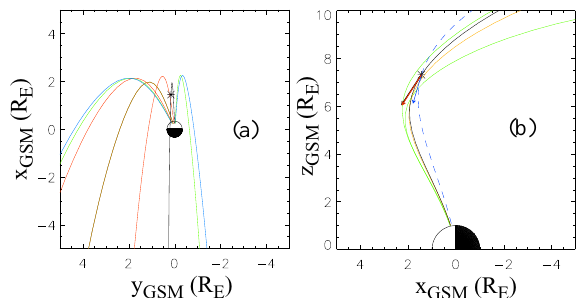
Fig. 10. Mapping of magnetic field lines from the ionospheric pro- ton spot into the magnetosphere. Different colours start at differ- ent brightness levels around the centre of the proton spot. Arrows represent magnetic field vectors at the Cluster location from actual measurements (red) and the Tsyganenko-01 model with exagger- ated solar wind dynamic pressure. (From Phan et al.,